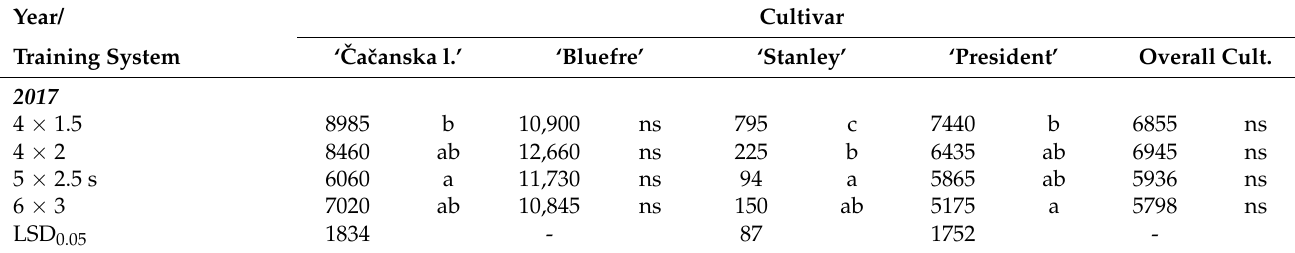
Table 6. The effects of the effects of years (2017, 2018 and 2019); training systems (4 × 1.5, 4 ×